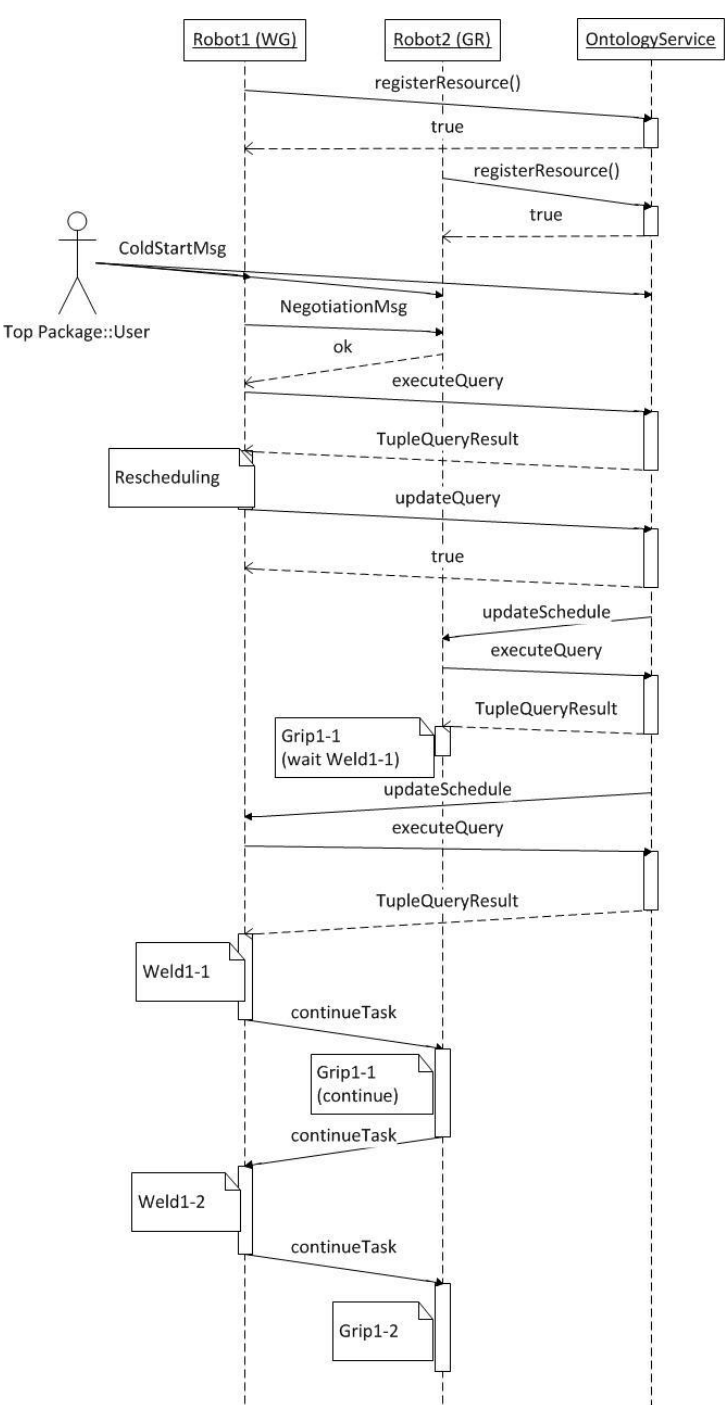
Figure 10. Scenario sequence diagram.